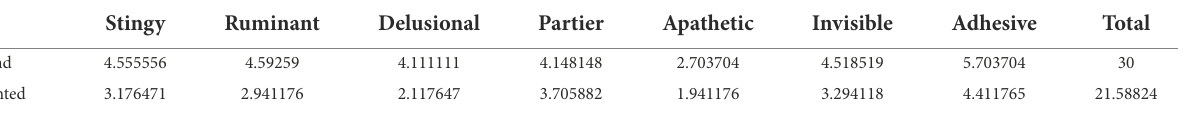
TABLE 4 Average number of responses to questionnaire 2.